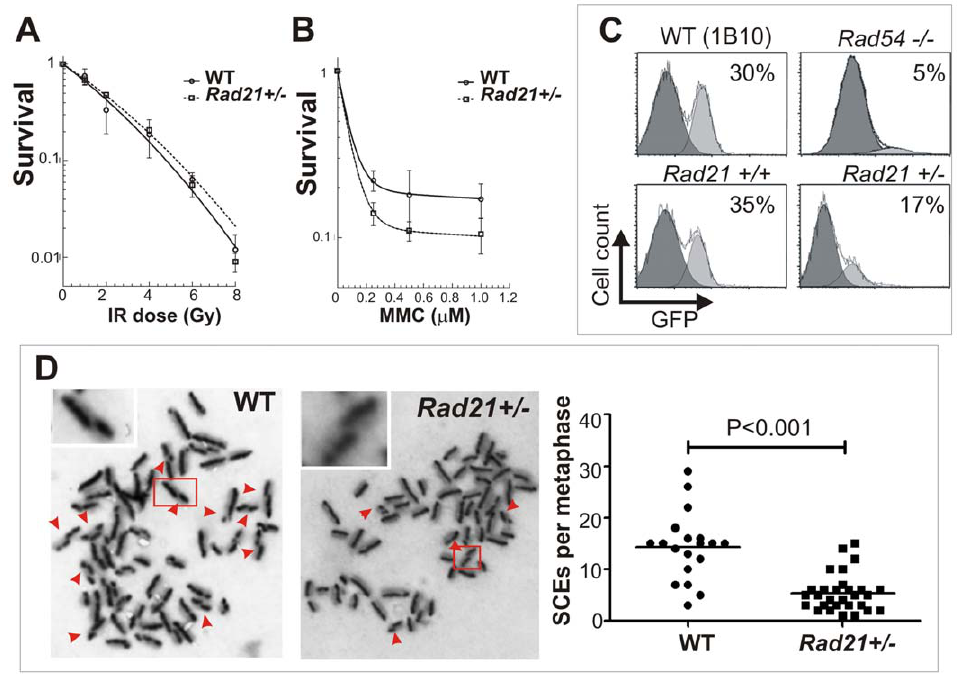
Figure 1. HR deficiency of Rad21 + / 2 cells. A . Clonogenic survival of WT and isogenic Rad21 + / 2 ES cells following IR. B . Clonogenic survival of Rad21 + / 2 ES cells following MMC indicated that Rad21 + / 2 ES cells were more sensitive to MMC than WT ES cells. C . Gene targeting efficiency in Rad21 + / 2 ES cells. Rad54 2 / 2 and its isogenic parental 1B10 ES cell line were used as gene targeting-defective and -proficient controls, respectively. D . SCE frequency in WT and isogenic Rad21 + / 2 MEFs following treatment with 6 m M MMC. Red arrowheads indicate SCEs. Inserts: enlarged images of boxed regions. The number of metaphase spreads scored: WT n=19; Rad21 + / 2 n=29. Horizontal bars represent the respective means.